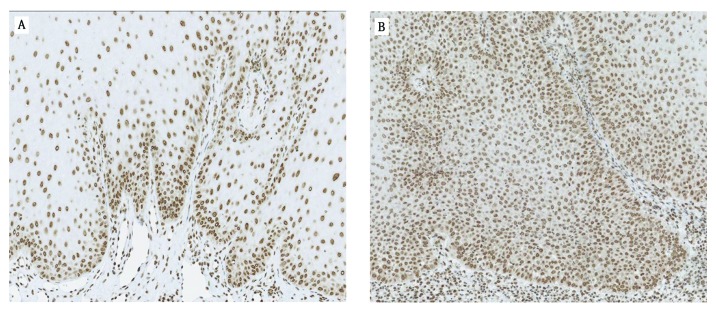
Comparison of HuR expression between the OVLs with low and high labeling indices (LIs). (A) In the low LI group (60% of cases), positive staining was noted in the lower one-third of the epithelium, whereas (B) in the high LI group (40% of cases) a positive signal extended to the lower two-thirds of the epithelium.